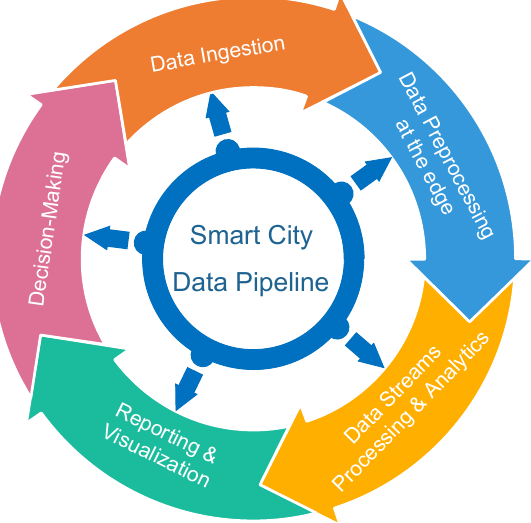
Figure 7. Phases of a smart city data